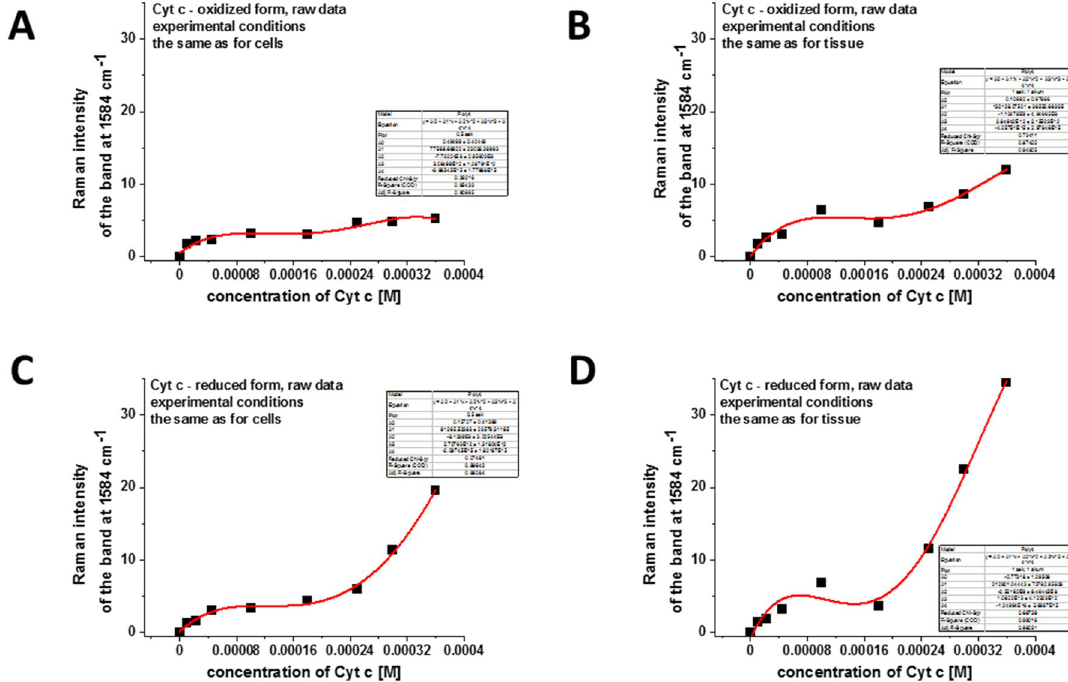
Figure 4. The intensity of Raman peak centered at 1584 cm −1 as a function of Cyt c concentration (raw data) for: ( A ) the oxidized form of Cyt c , experimental conditions the same as for breast single cells measurements: integration time 0.5 s, 1 accumulation, laser power 10 mW; ( B ) the oxidized form of Cyt c , experimental conditions the same as for breast tissue measurements: integration time 1.0 s, 1 accumulation, laser power 10 mW; ( C ) the reduced form of Cyt c , experimental conditions the same as for breast single cells